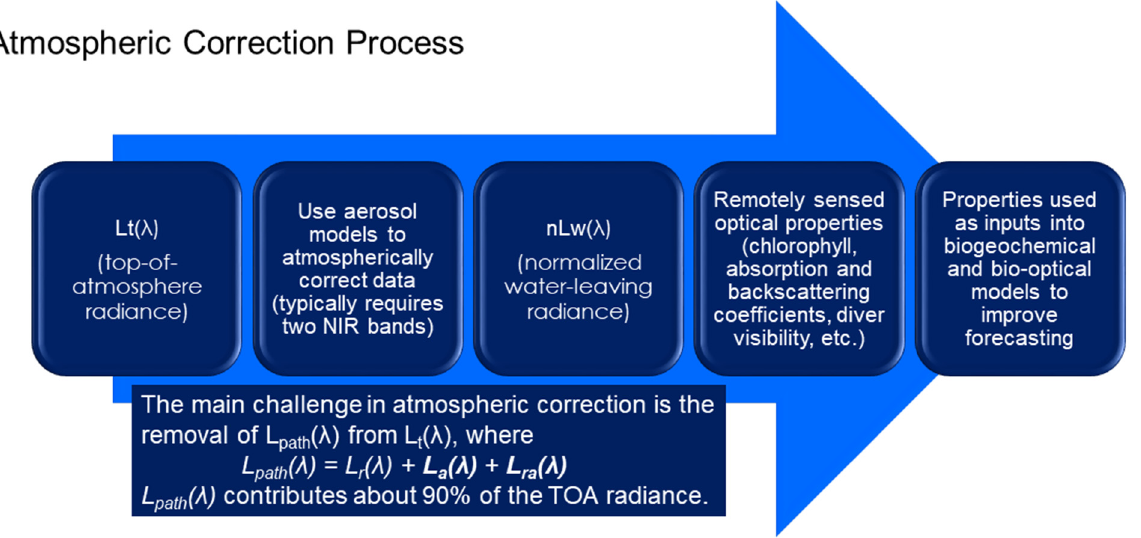
Figure 1. Standard atmospheric correction process implemented within NRL’s APS, built upon NASA’s SeaDAS processing code.